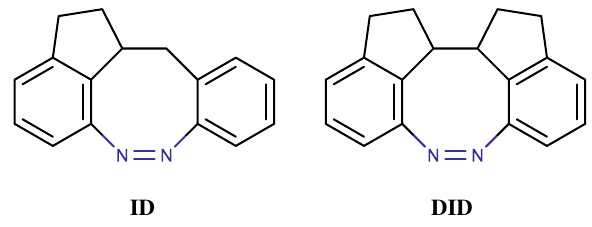
Figure 1. Schematic view of the studied compounds. For stereo- information, see Figure 2.